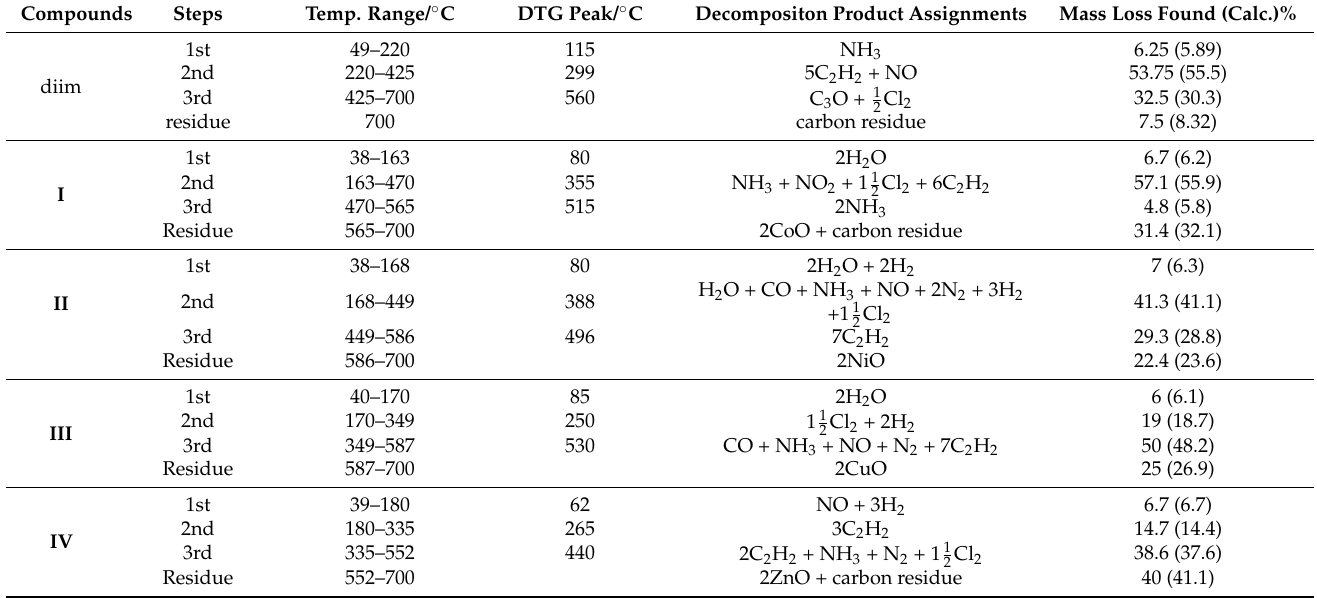
Figure 7. TGA-DrTGA curves of ( a ) diim free ligand, ( b ) cobalt(II) complex, ( c ) nickel(II) complex, ( d ) copper(II) complex and ( e ) zinc(II) complex. Table 3. Thermo gravimetric data of the diim ligand and its metal complexes.